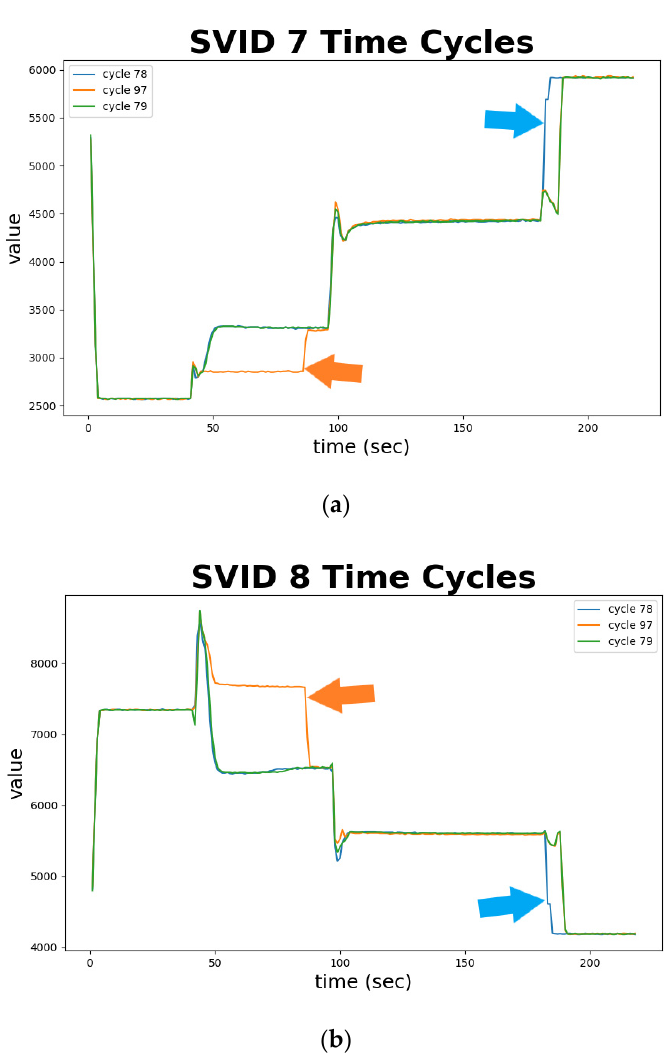
Figure 11. Two abnormal sequences identified against a normal sequence in time series of two SVIDs: